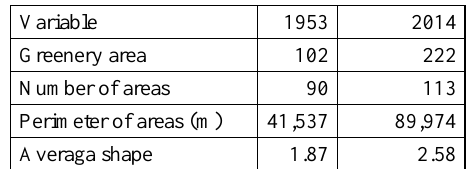
Table 1. The results of the quantitative